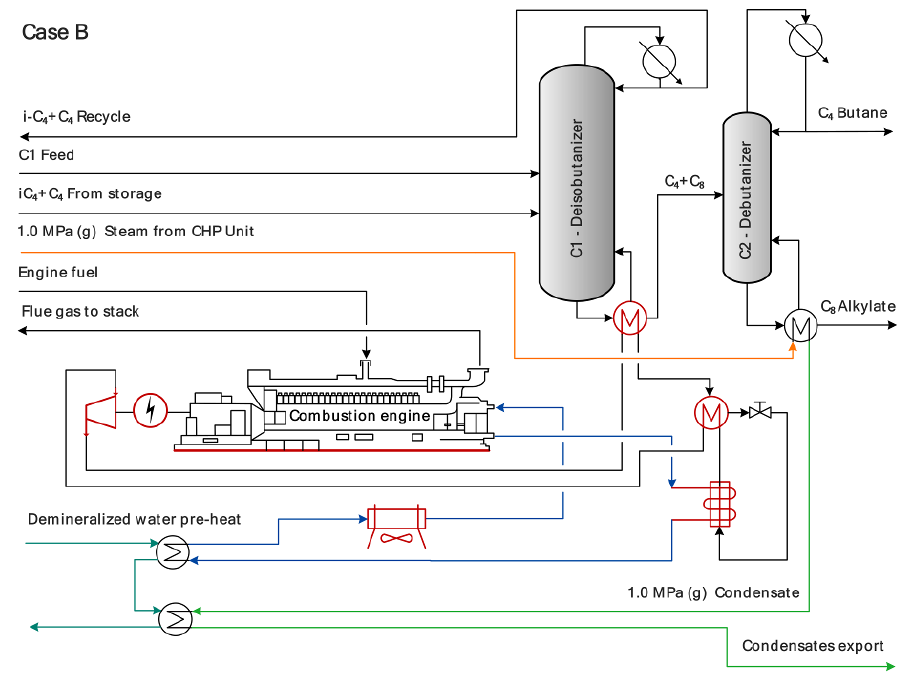
Figure 7. Combustion engine-based heat pump-assisted distillation: “Case B”. New equipment, compared to the process layout depicted in Figure 5, is highlighted in red.